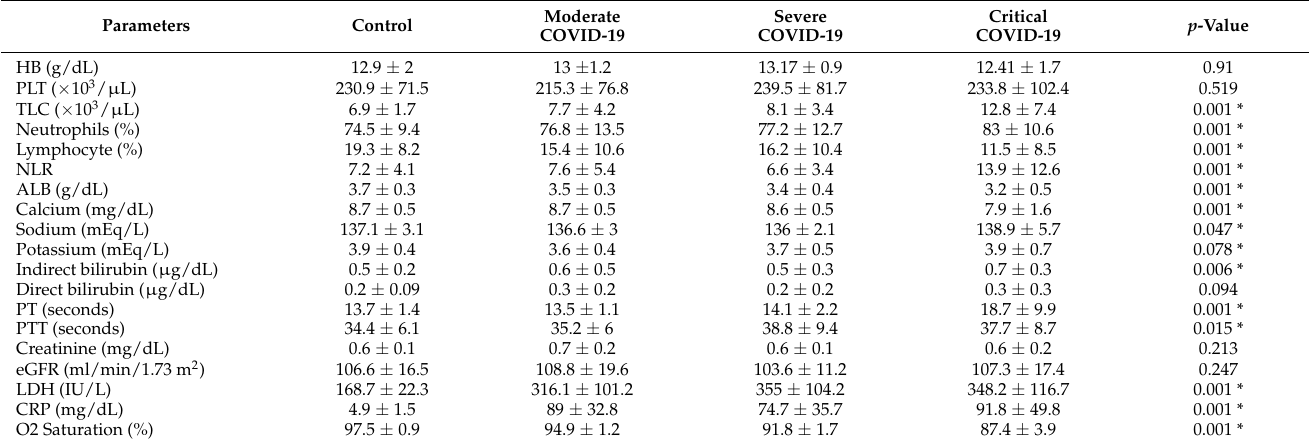
Table 2. Baseline laboratory findings of studied COVID-19 patients.